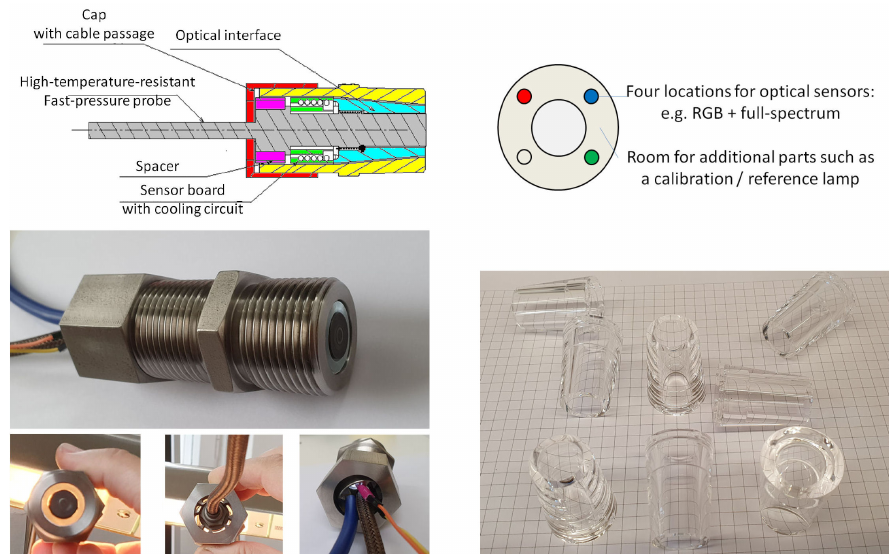
Figure 7. High-pressure, high-temperature-resistant Rayleigh Criterion Probe: ( top ) cutaway and principle including colour photodiodes arrangement and ( bottom ) pictures of the actual probe and details of the optical